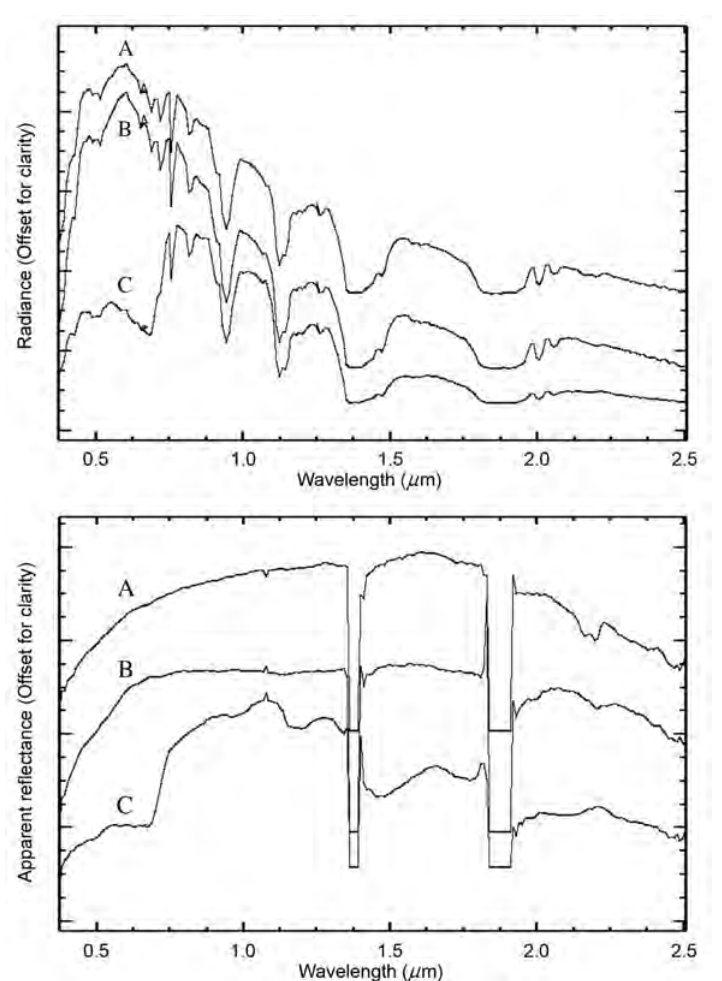
Fig. 3. Comparison of selected AVIRIS radiance spectra ( top ) and corresponding ACORN reflectance spectra ( bottom ). Spectrum A is a kaolinite-bearing rock, spectrum B a clay-bearing rock, and spectrum C is green veg-